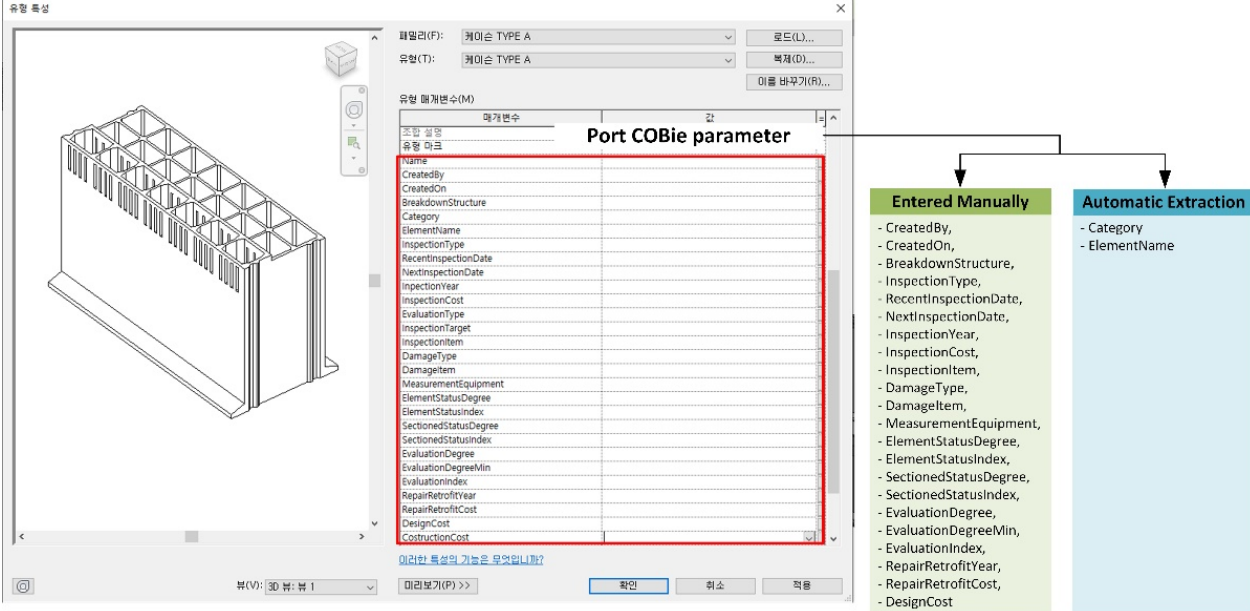
Figure 12. COBie data classification (e.g., caisson).